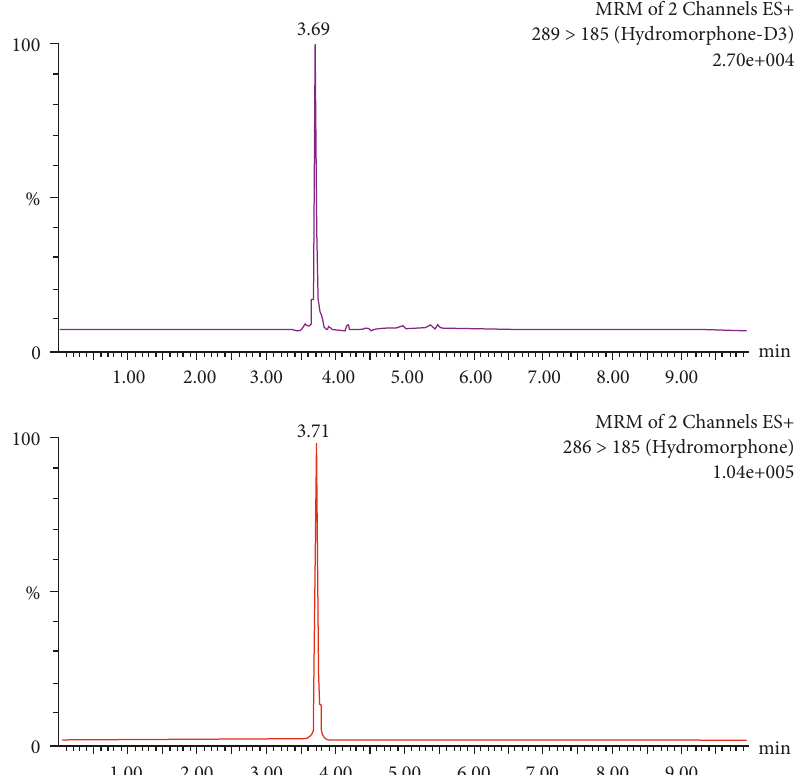
Figure 3: Chromatogram of a patient sample (patient plasma plus internal standard). The internal standard hydromorphone-D3 is presented in the upper panel and hydromorphone in the lower panel, respectively.